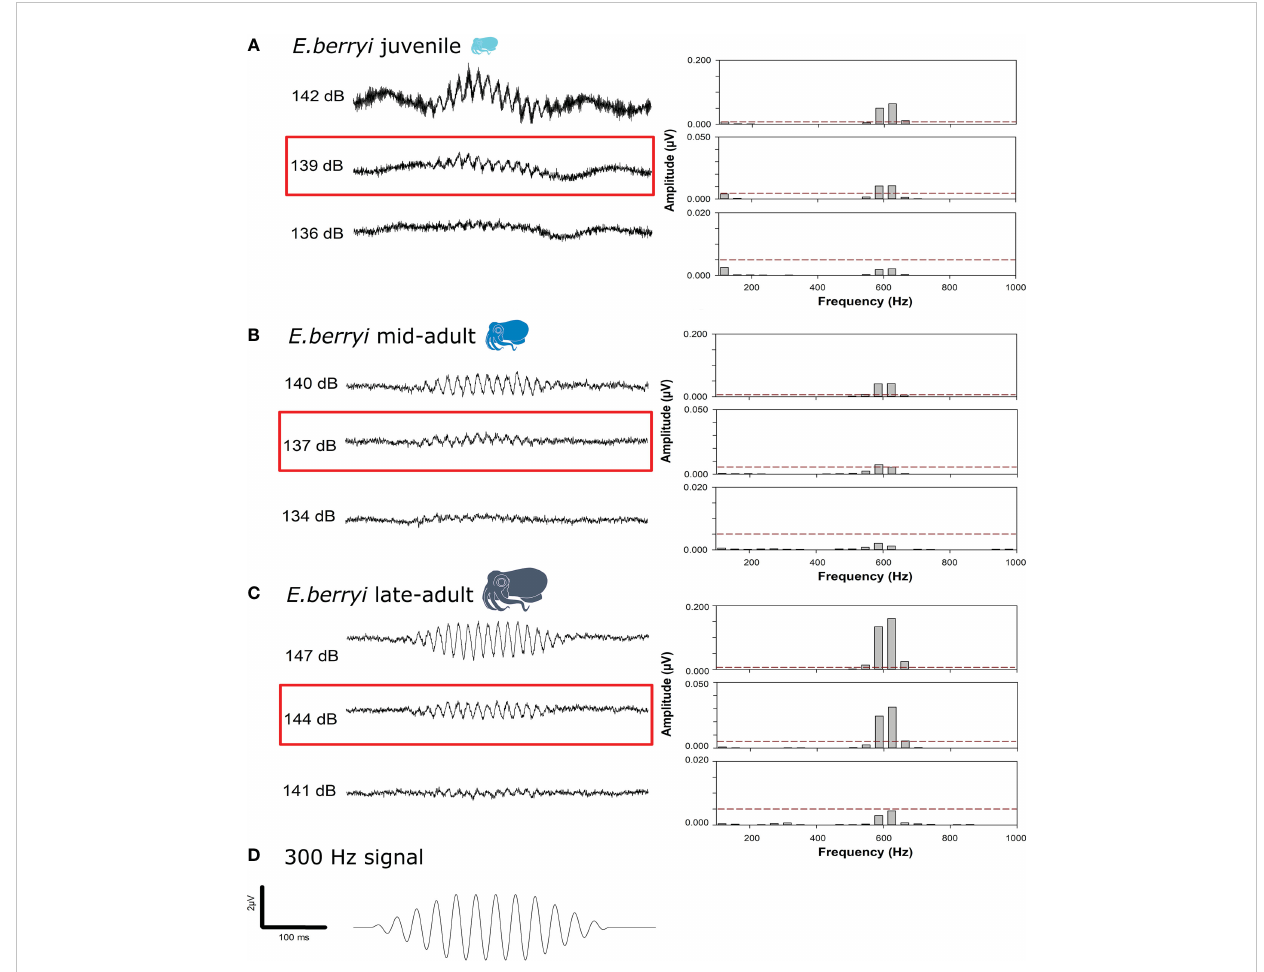
FIGURE 2 Auditory evoked potential (AEP) response for (A) juvenile; (B) mid-adult and (C) late-adult hummingbird bobtail squid ( E. berryi ) to (D) the 300 Hz signal presented. Each panel (A – C) displays the average AEP trace (500 repetitions) for the indicated sound pressure level (dB re. 1 µPa) on the left and the fast Fourier transformation (FFT) on the right. Please note the y axis for the FFT data varies. FFT peaks are twice the stimulus frequency (600 Hz) owing to the opposed orientation of the hair cells. AEP thresholds (0.005 µV) for each age group are highlighted in